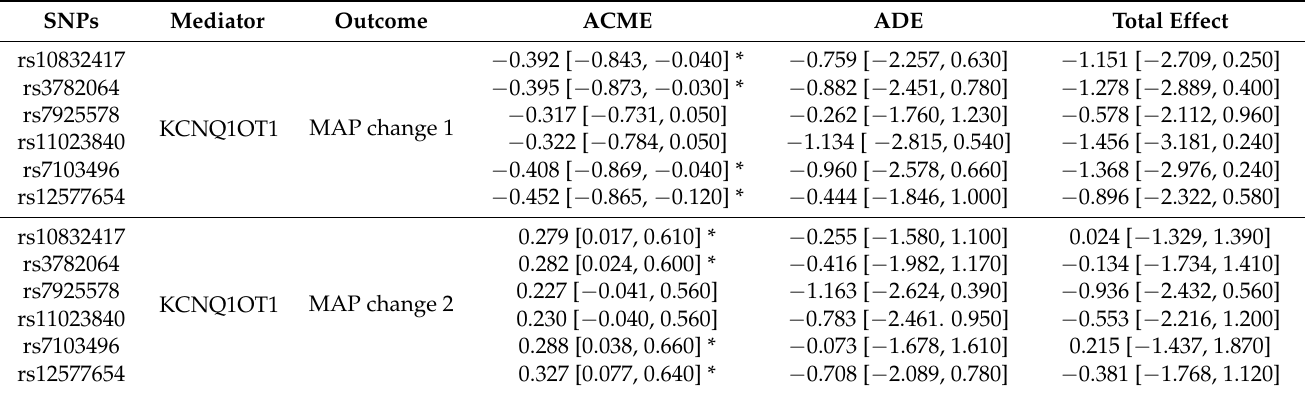
Table 3. ACME, ADE, and total effect and their 95% Cls between SNP and SSBP. * p < 0.01.